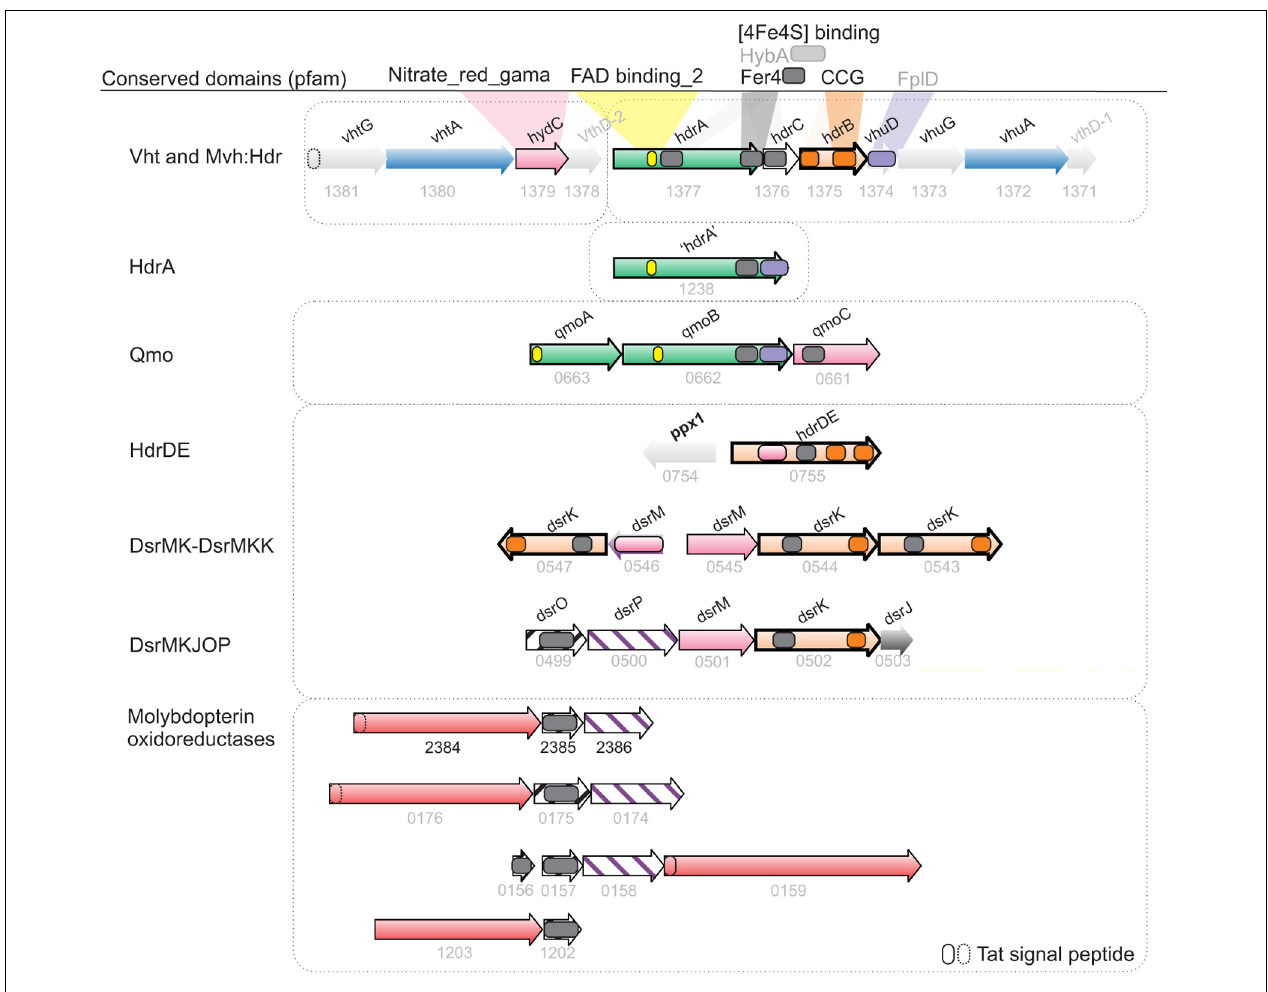
FIGURE 4 | Synteny and homology between hydrogenases and menaquinol oxidases potentially involved in energy conservation in A. fulgidus . Hypothetical bifurcating and ferredoxin interacting genes (green), Menaquinone reductase/Menaquinol oxidase (pink/purple